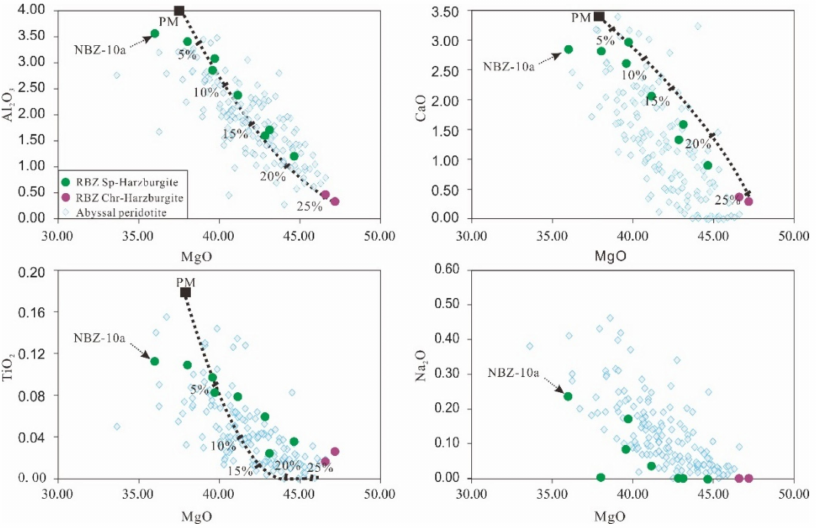
Figure 4. Compositions of major elements (wt.%) of harzburgites from the Raobazhai complex. The polybaric melting curve at 25–10kbr from [27] and abyssal peridotite data from